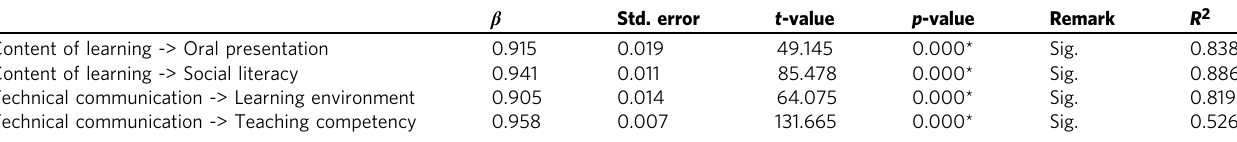
Table 13 Relationship testing for the HOCs.